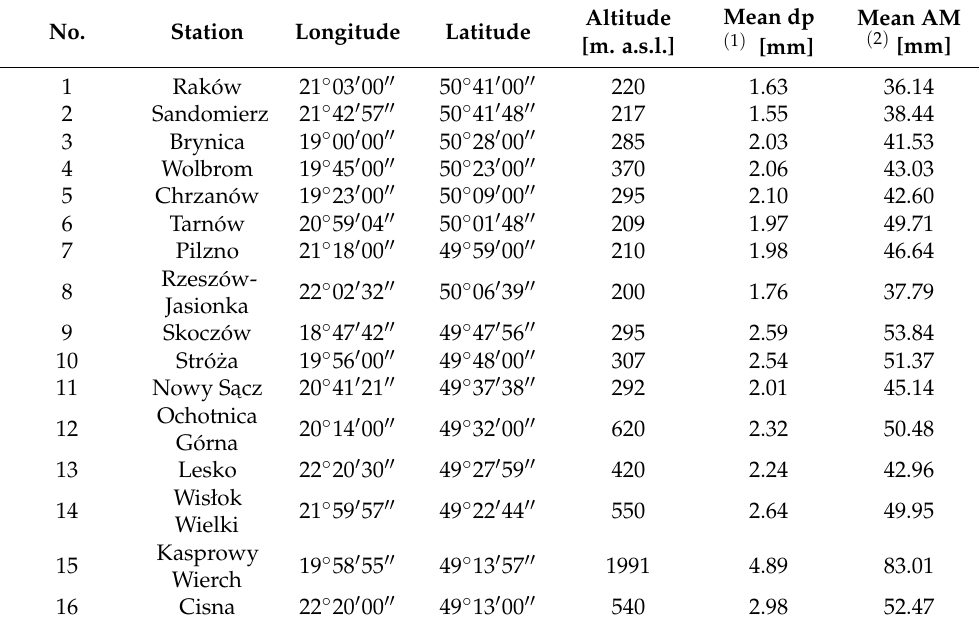
Table 1. The stations used in the study and their main characteristics [37,38].